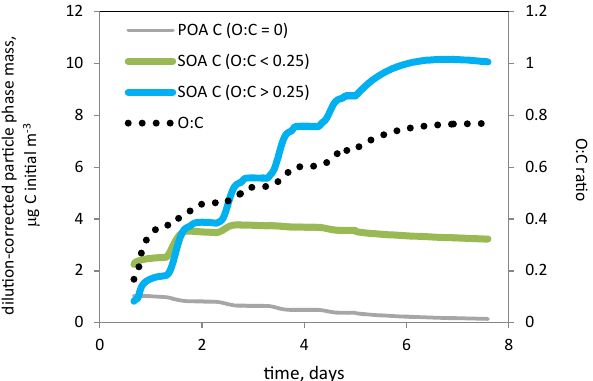
Figure 5. Evolution of the O:C ratio in the particle phase for the urban case. Left axis and solid lines: plume-integrated carbon mass of particle-phase fractions, segregated by O:C ratio. Right axis and black dotted line: O:C ratio of the entire particle